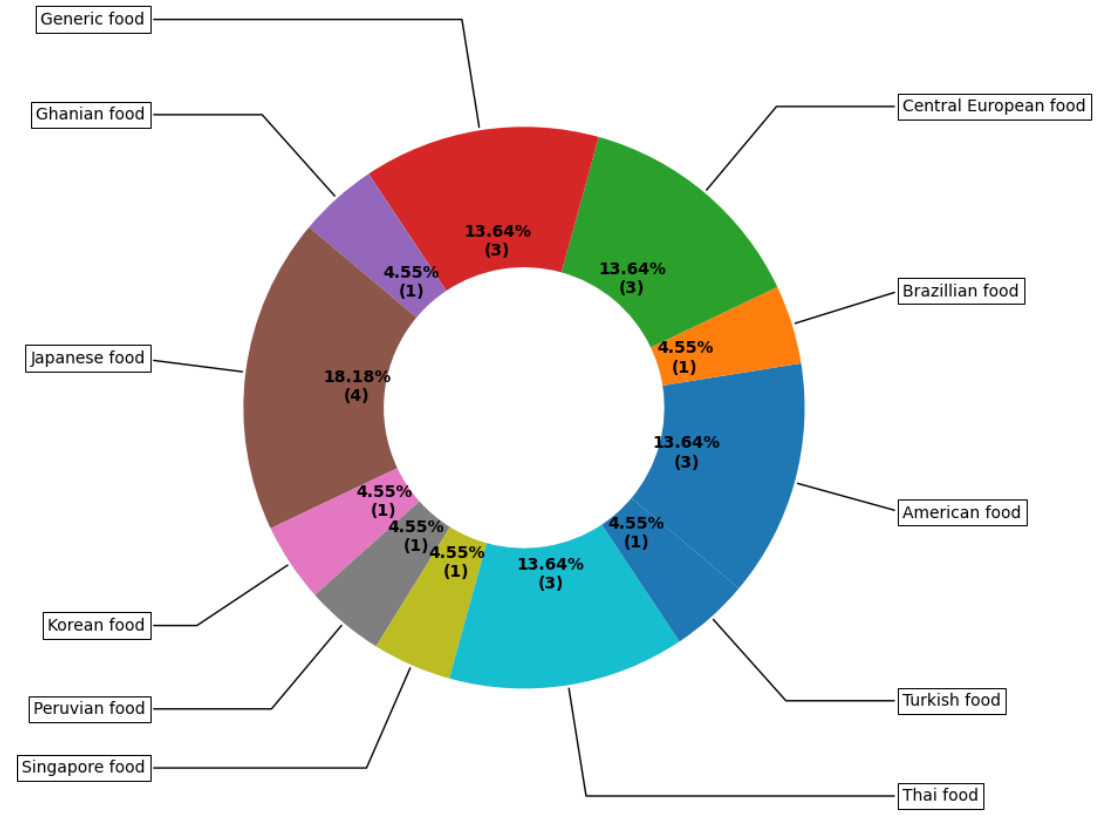
Figure 4. The percentages of datasets used in mobile computer vision-based applications for food recognition and volume estimation. Note: Generic food refers to when more than one multicultural dataset was used. The number in brackets refers to implemented vision-based applications that have used a particular dataset from surveyed studies.